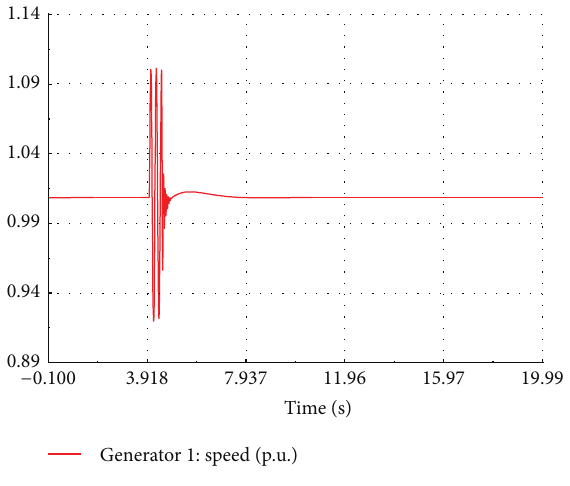
Figure 15: Simulated speed of FSWEG1. Figure 17: Simulated capacitor switching waveform. events with time duration between 0.3 sec and 1 min and nine events with time duration between 1.1 min and 3 min are recorded as per EN50162 standard. The induction motor load is connected to the 11 kV busbar at 𝑡 = 4 seconds during simulation. The sag event is observed during the simulation period of 10 seconds. The voltage at the transformer busbar drops to 0.88 p.u. for a duration of 0.7 seconds as shown in Figure 18. The dip in voltage depends on the short circuit ratio of the grid. For a weak grid, the percentage of voltage dip is high. The active power exported to the grid is reduced and the electromagnetic torque drops to 0.87 p.u. causing an increase EMT simulation of instantaneous line voltage of generator waveform as shown in Figure